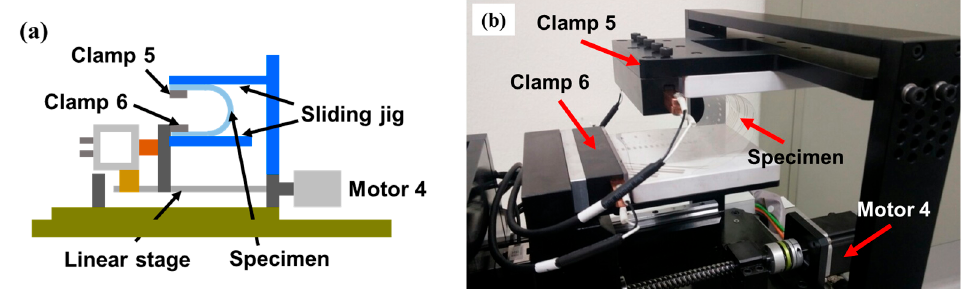
Figure 4. Configuration for sliding test ( a ) schematic; ( b ) actual photograph.